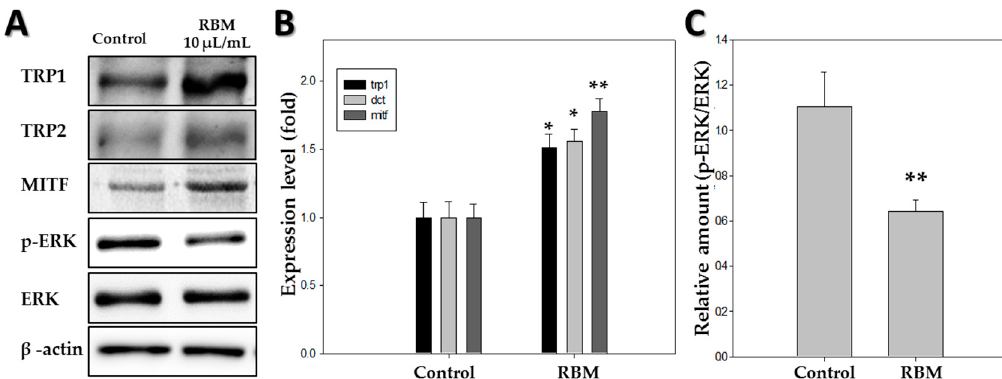
Figure 3. Effect of rice bran ash mineral extract (RBM) on protein levels of tyrosinase-related protein 1 (TRP1), microphthalmia-associated transcription factor (MITF), tyrosinase-related protein 2 (TRP2), and β -actin in zebrafish ( n = 30) at 5 dpf. ( A ) Western blotting analysis of pigmentation-related proteins; ( B ) Expression levels of TRP1, TRP2, and MITF; ( C ) Level of p-ERK (extracellular signal-regulated kinase). Each bar represents the mean ± standard error of independent experiments performed in triplicate ( n = 5). (* p < 0.05, ** p < 0.01, compared to control).